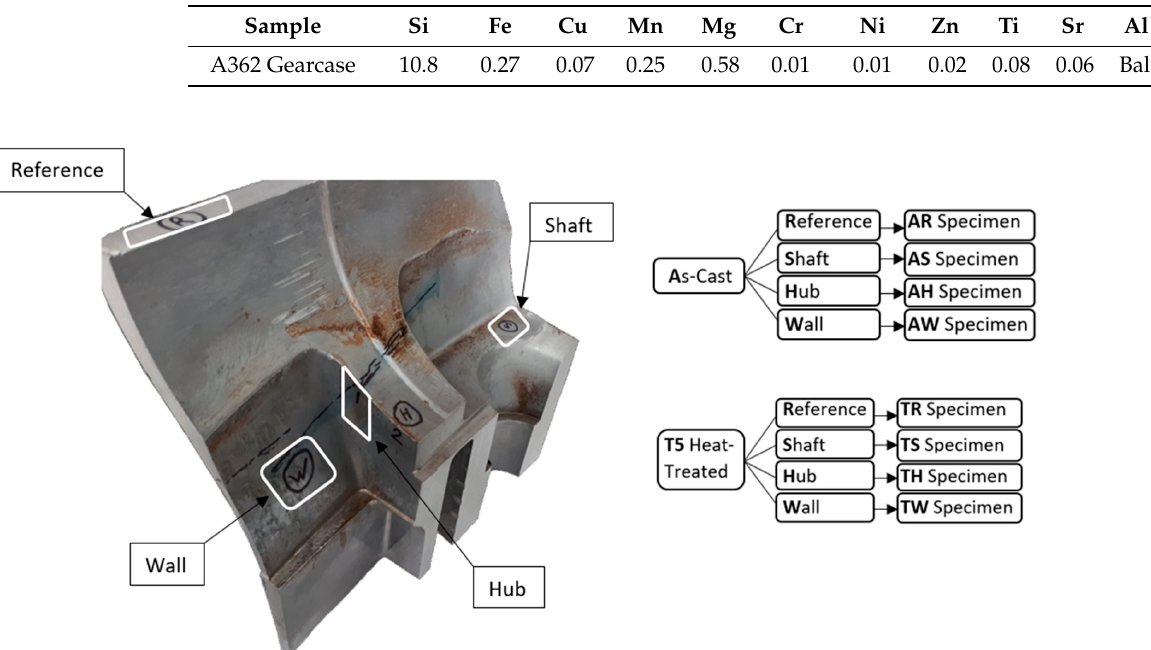
Figure 1. Locations and naming scheme of the samples taken from the gearcase.